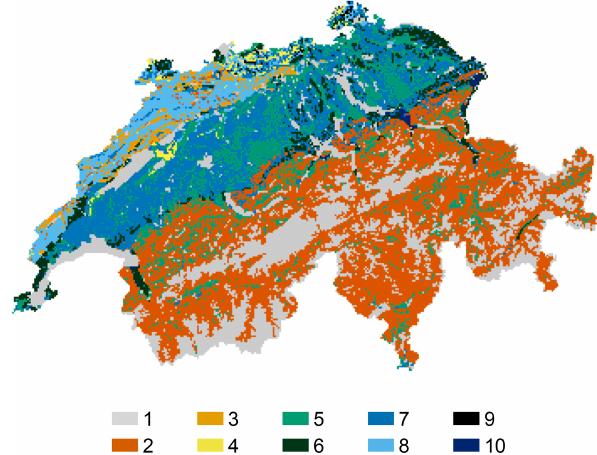
Figure D1. Soil code used in LPJ-GUESS simulations. 1 – urban, rocky or water areas (no forest growth); 2 – E: 5.0, V: 0.110, D0: 0.2, D15: